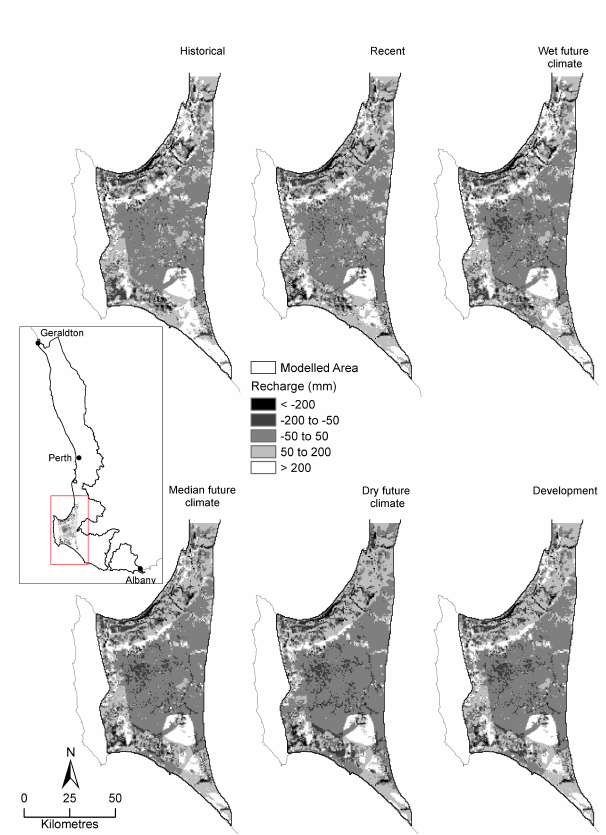
Fig. 3. Annual average recharge (mm) in the SWAMS model